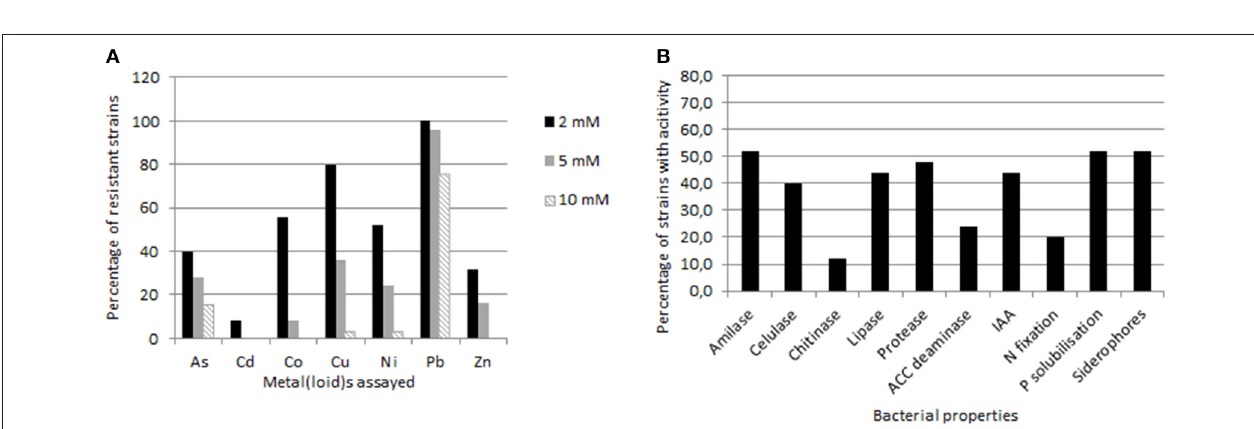
FIGURE 3 | Graphics showing percentages of studied strains (A) with resistance to different heavy metals over concentrations of 2mM, 5mM or 10mM, and (B) with enzymatic and plant growth promoting properties.